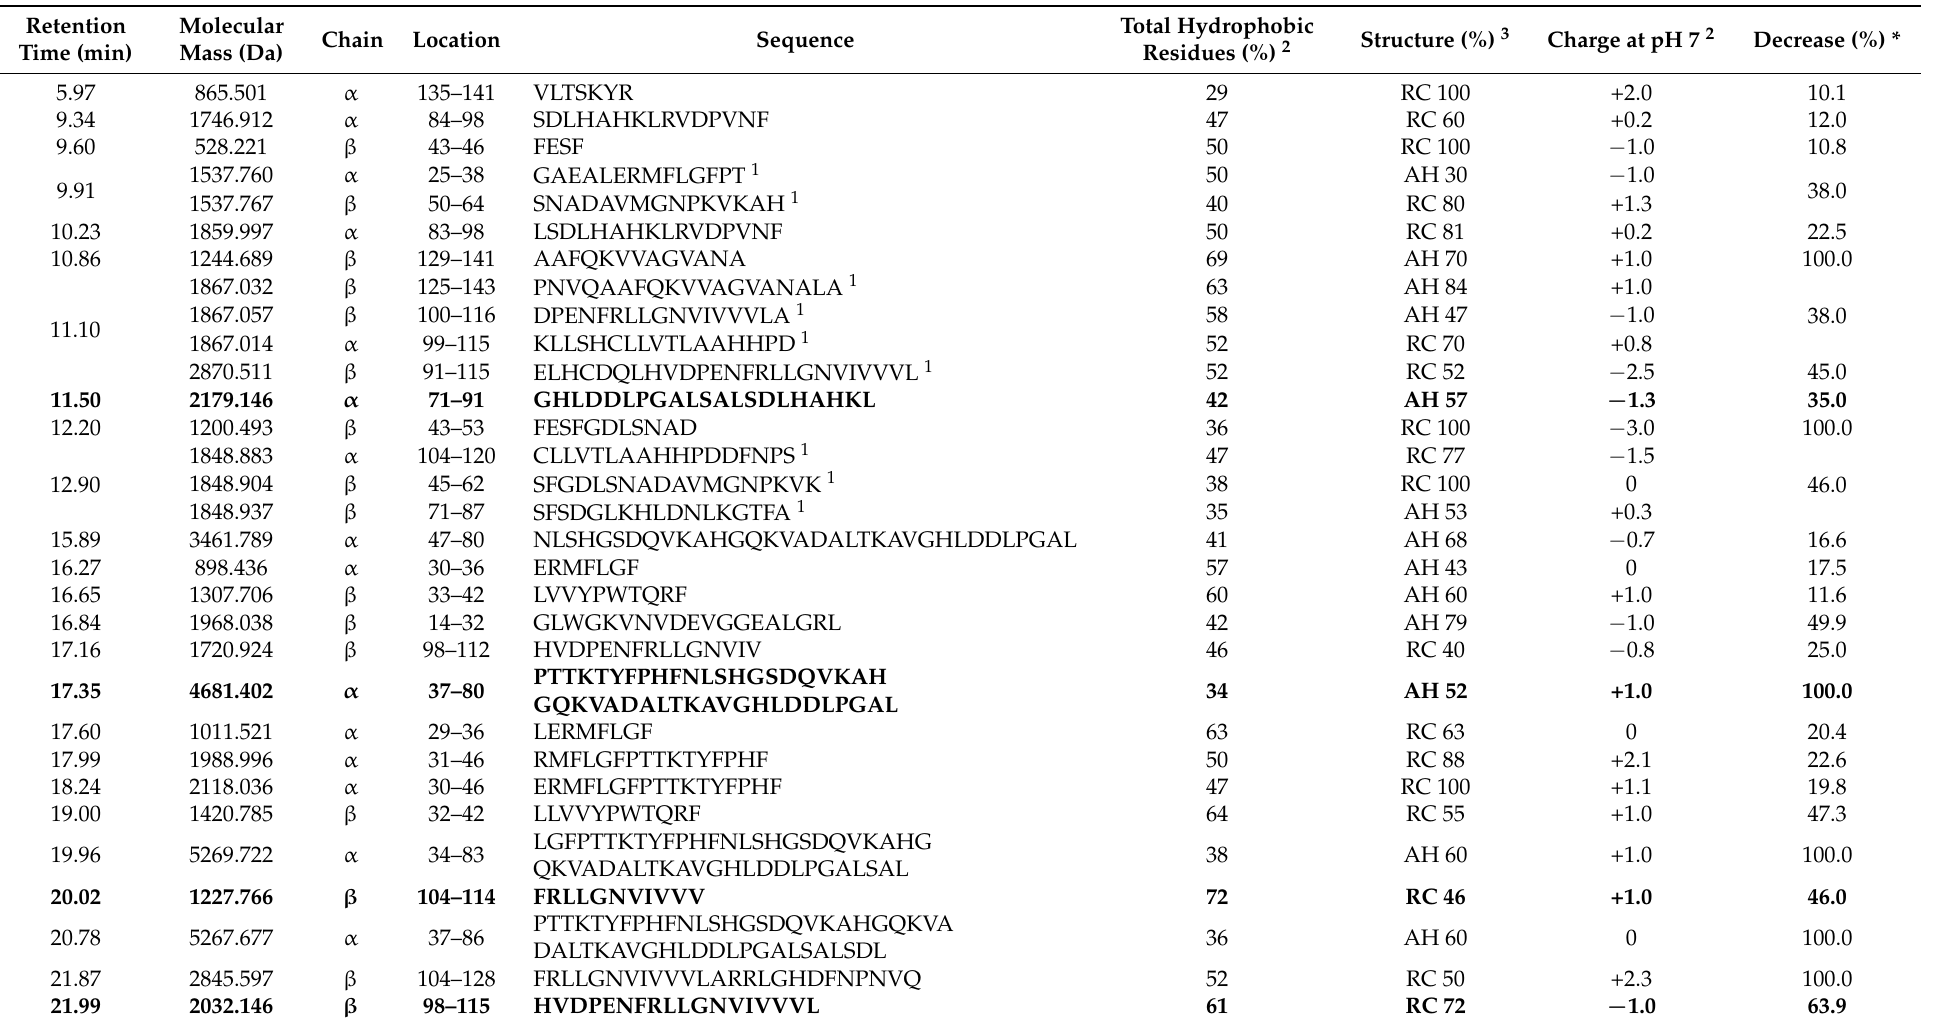
Table 4. Peptides absent or diminished in the discolored porcine cruor